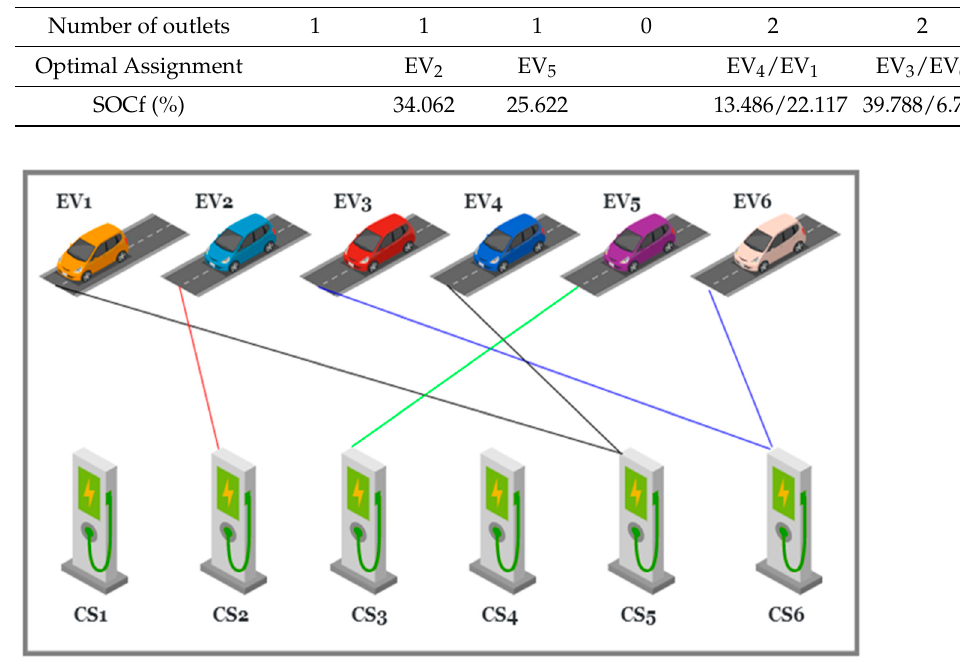
Figure 10. Optimal assignment of EVs. Table 4. Optimal values of assignment according to the value of the